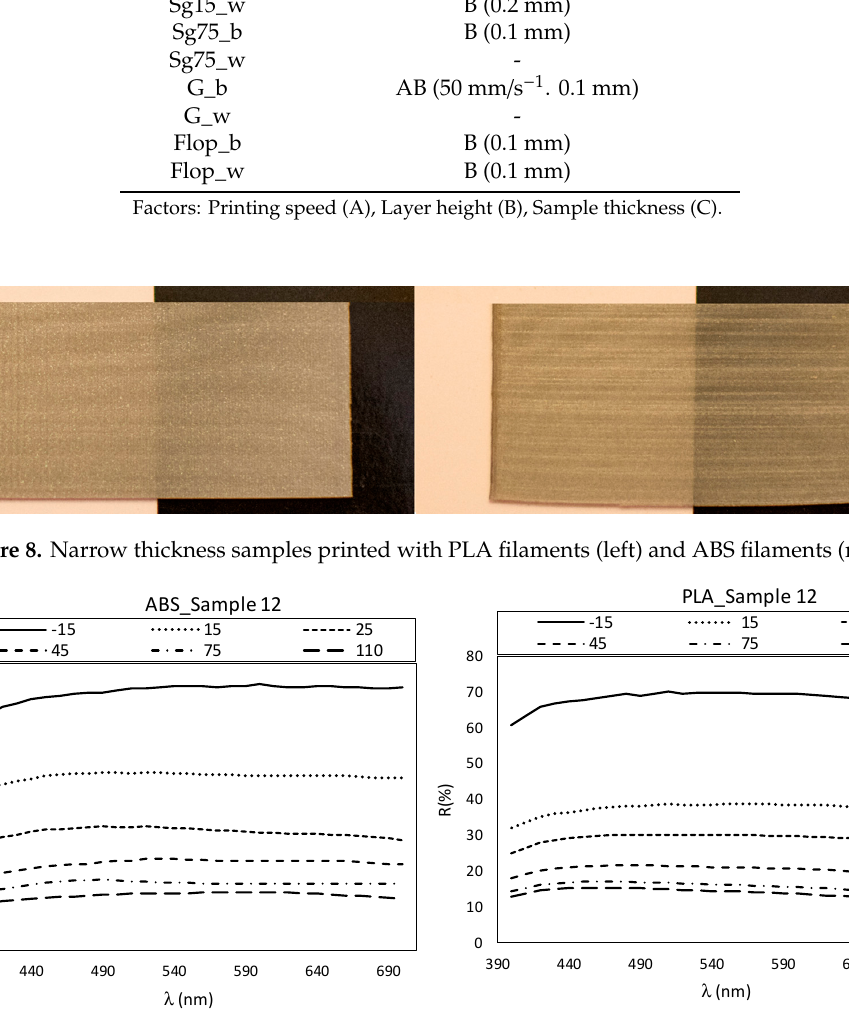
Figure 9. Visible reflectance spectrum values from PLA and ABS sample 12 in DoE conditions.